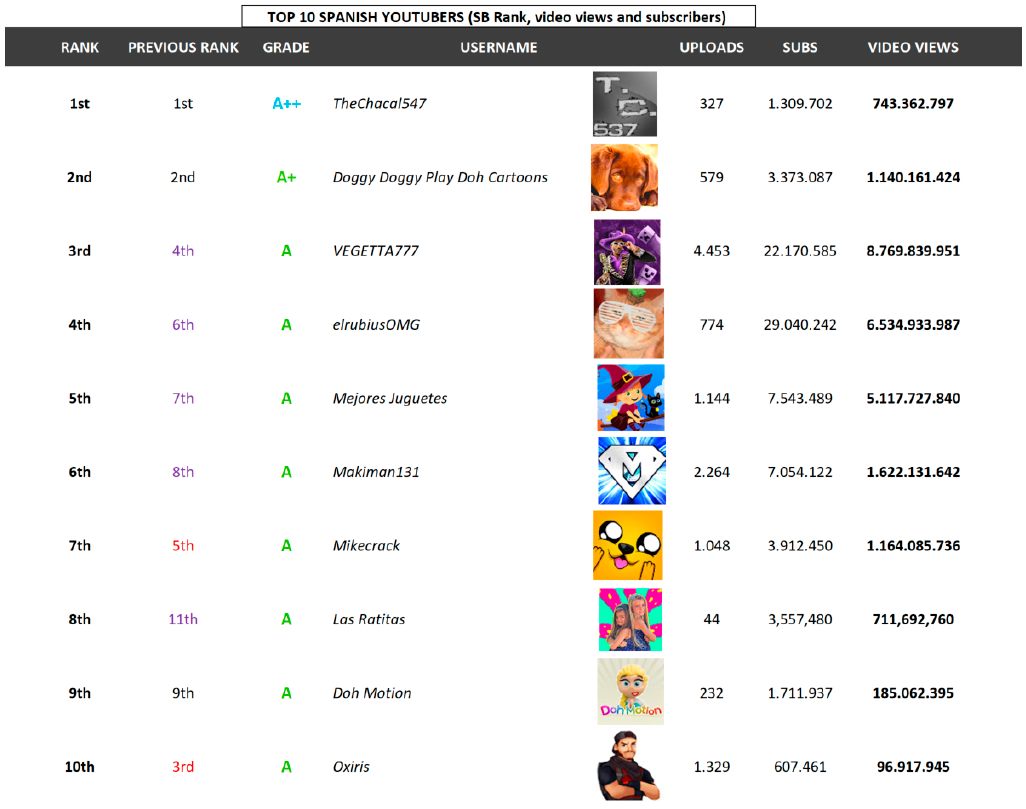
Figure 2. Top 10 Spanish YouTubers sorted by SB Rank.